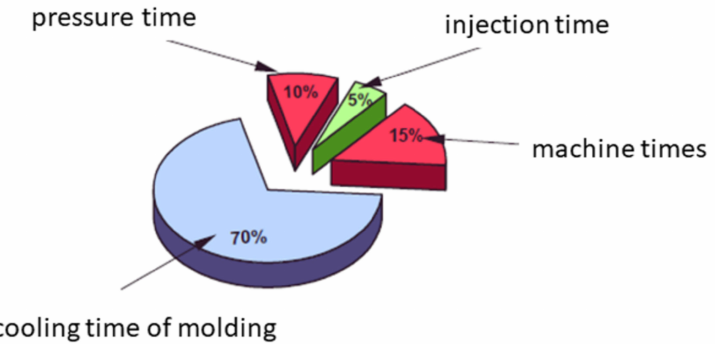
Figure 3. The structure of the most important technological times in the injection molding